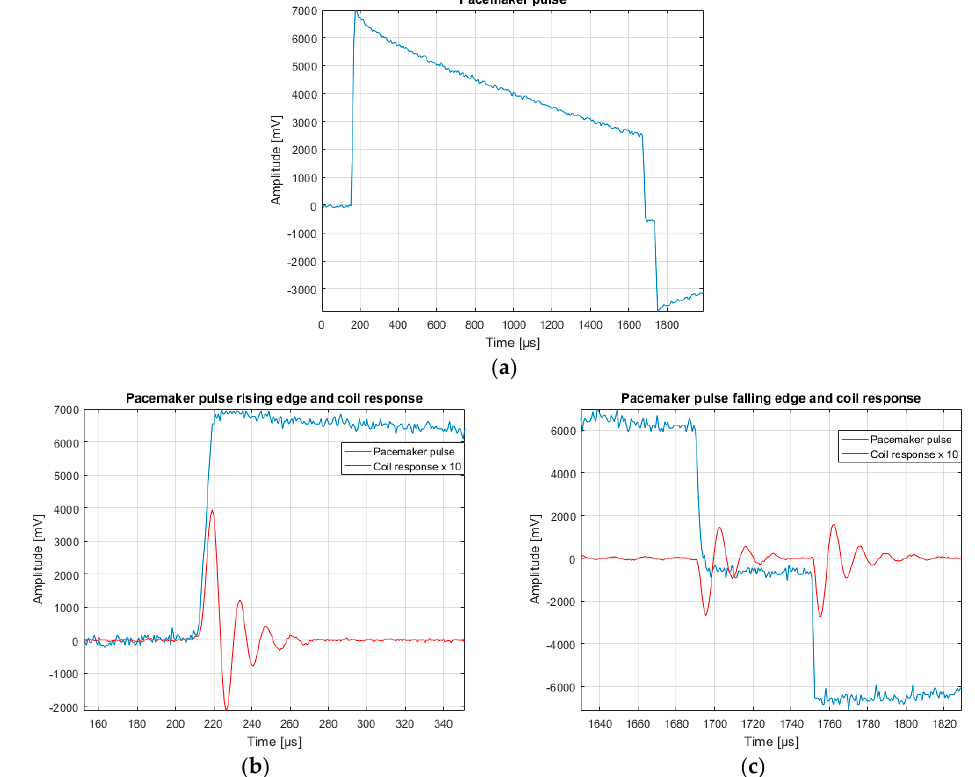
Figure 11. ( a ) Pulse waveform of St. Jude Medical™ Accent MRI pacemaker. It is possible to see a pair of negative falling edges. ( b ) Detail of pulse rising edge and relative coil response. ( c ) Detail of pulse falling edge and relative coil response. As expected, there is a pair of negative damped sine pulses corresponding to the pair of falling edges, i.e., two EMF negative pulses.